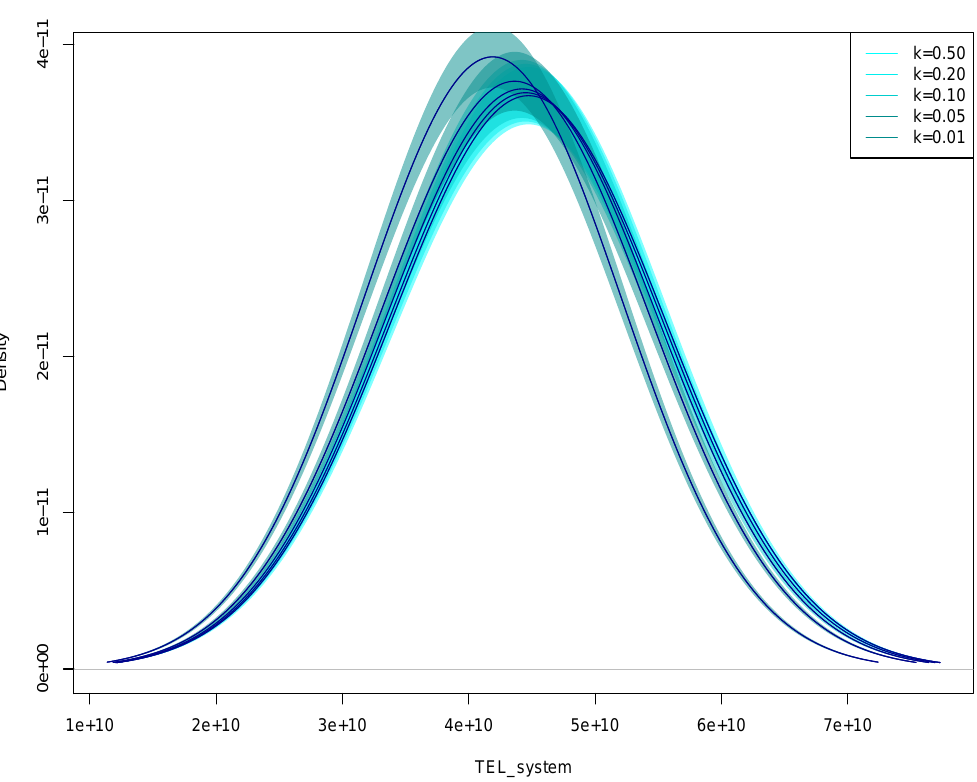
Figure 9. Sensitivity analysis as a function of the parameter k . Notes: Monte Carlo simulated distributions of the expected losses of the entire banking system in case Monte dei Paschi di Siena is close to its default point, calculated as a function of the bail-in parameter k at time t 1 within the bail-in context. Even a strong change in the interbank exposures factor does not radically change the results, which thus appear to be robust with respect to our proposed